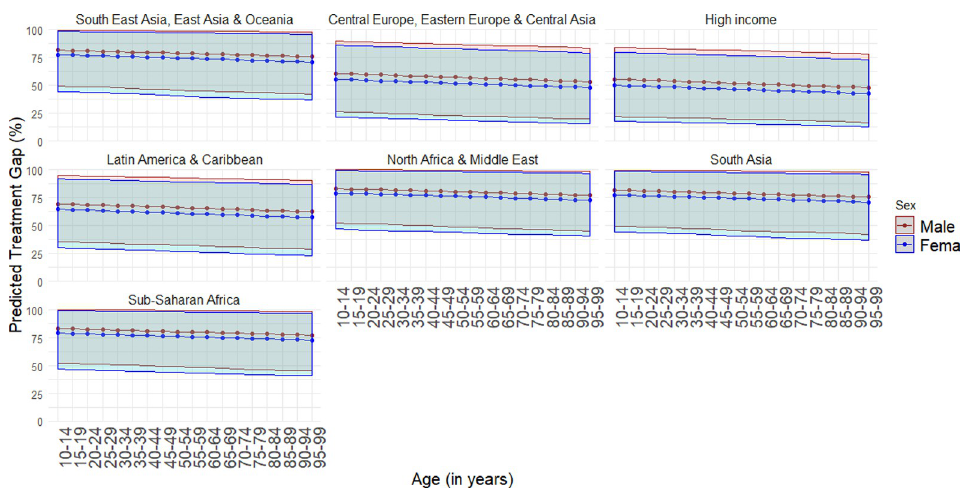
Fig 2. Predicted treatment gap (lines) and 95% UIs (shaded region) for any health service use by age, sex, and GBD superregion. Note: 95% UIs incorporate between-study heterogeneity. GBD, Global Burden of Disease; UI, uncertainty interval.